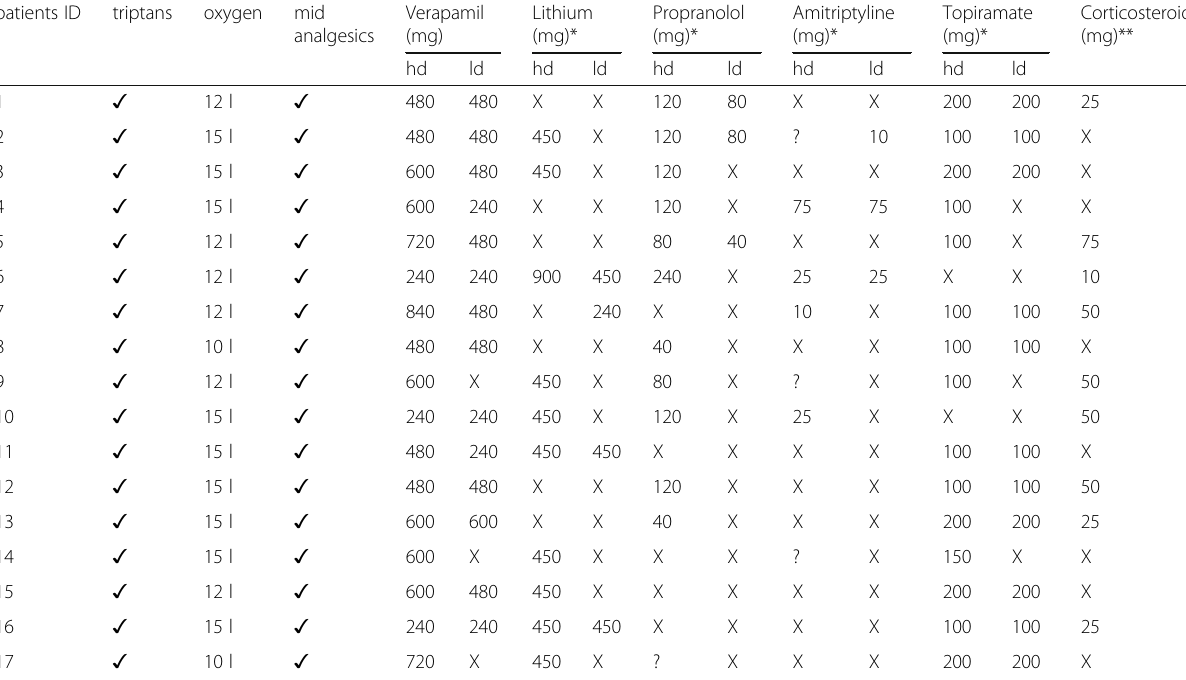
Table 1 Demographic details, medication used to manage CCH before enrolment in the study patients